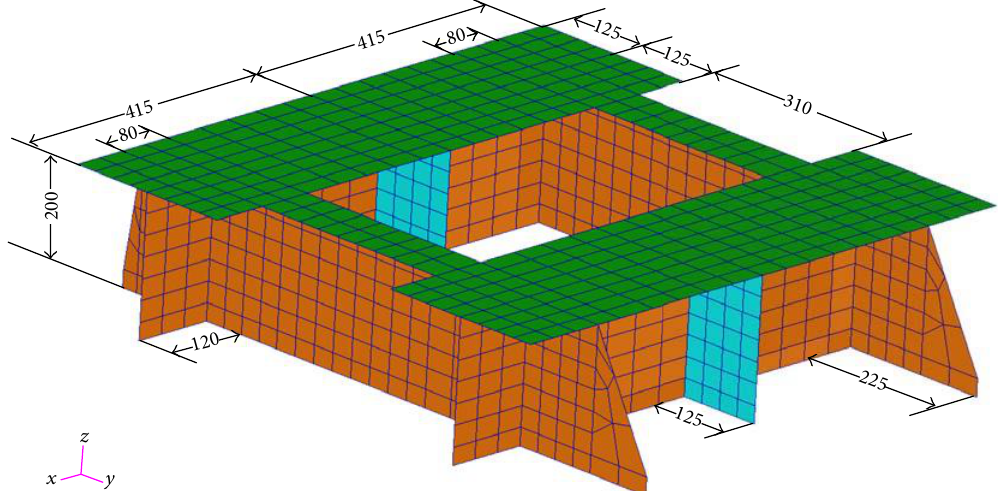
Figure 10: Traditional 500 kg class vibration isolation base, where the green parts are face plates, the brown parts are web plates, and the blue parts are